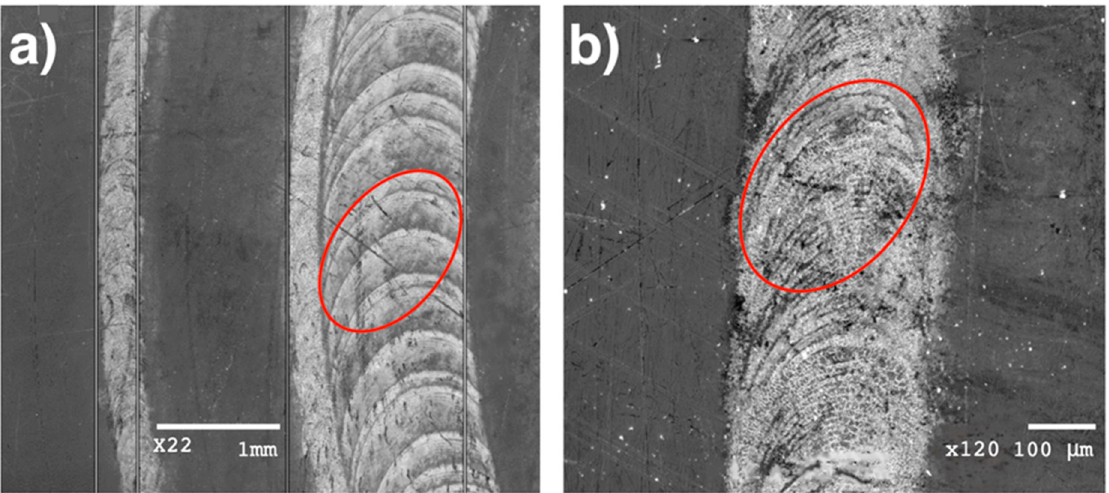
Figure 2. Low magnification SEM images of tracks written by tight and loose focusing with: ( a ) marking the contour of a spot of 1.01 mm 2 area and ( b ) a close-up of the track written focusing to the smallest spot of 0.085 mm 2 .